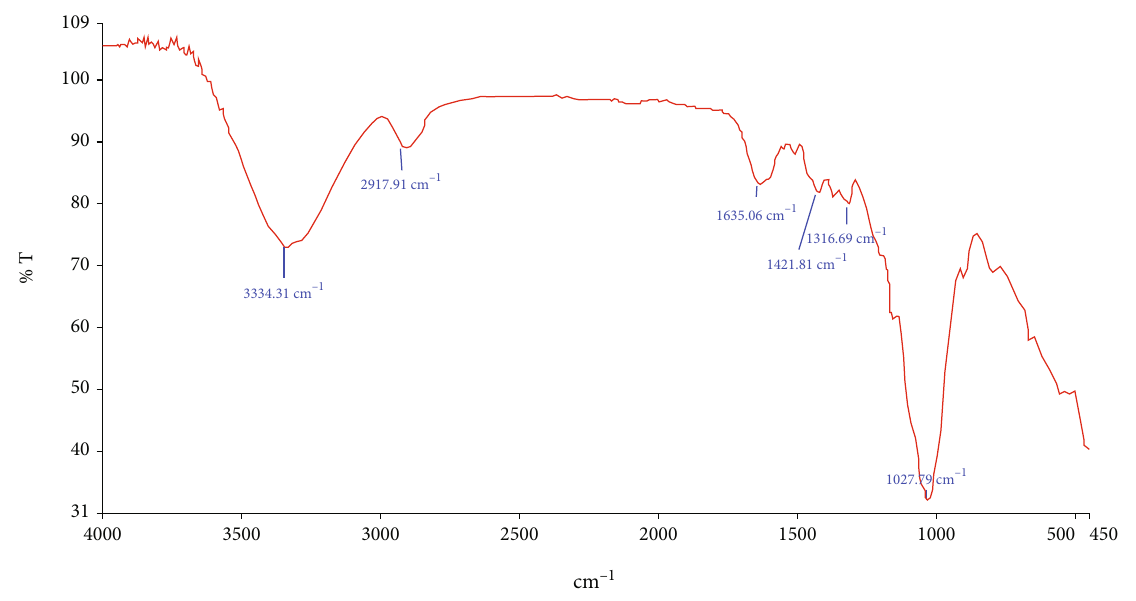
Figure 2: Infrared spectroscopy of untreated rice husk sample before adsorption.